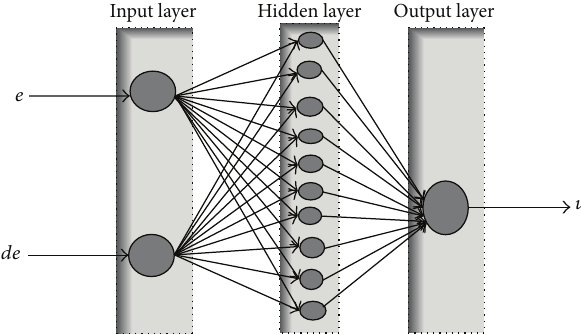
Figure 2: Neural architecture proposed for the implementation of